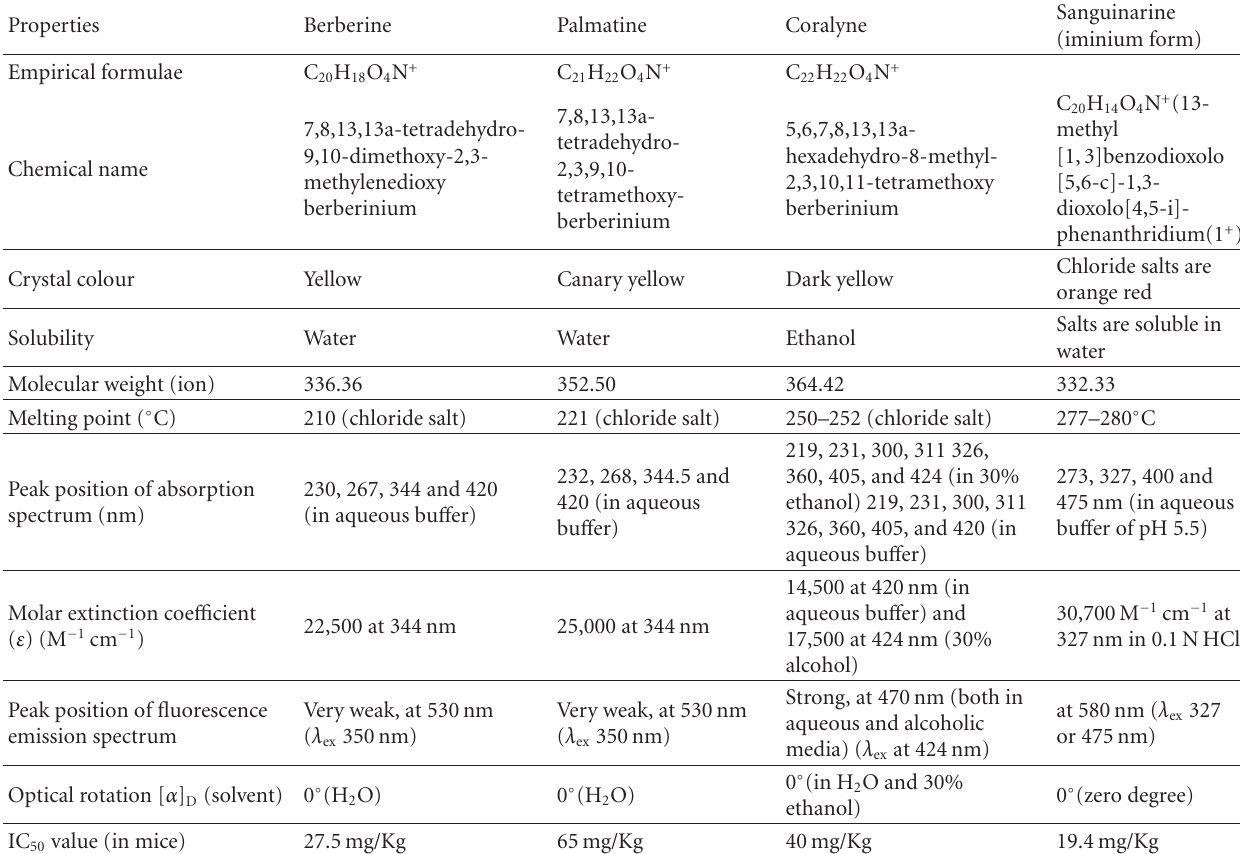
Table 1: Some physicochemical properties of isoquinoline alkaloids [15, 16, 27,